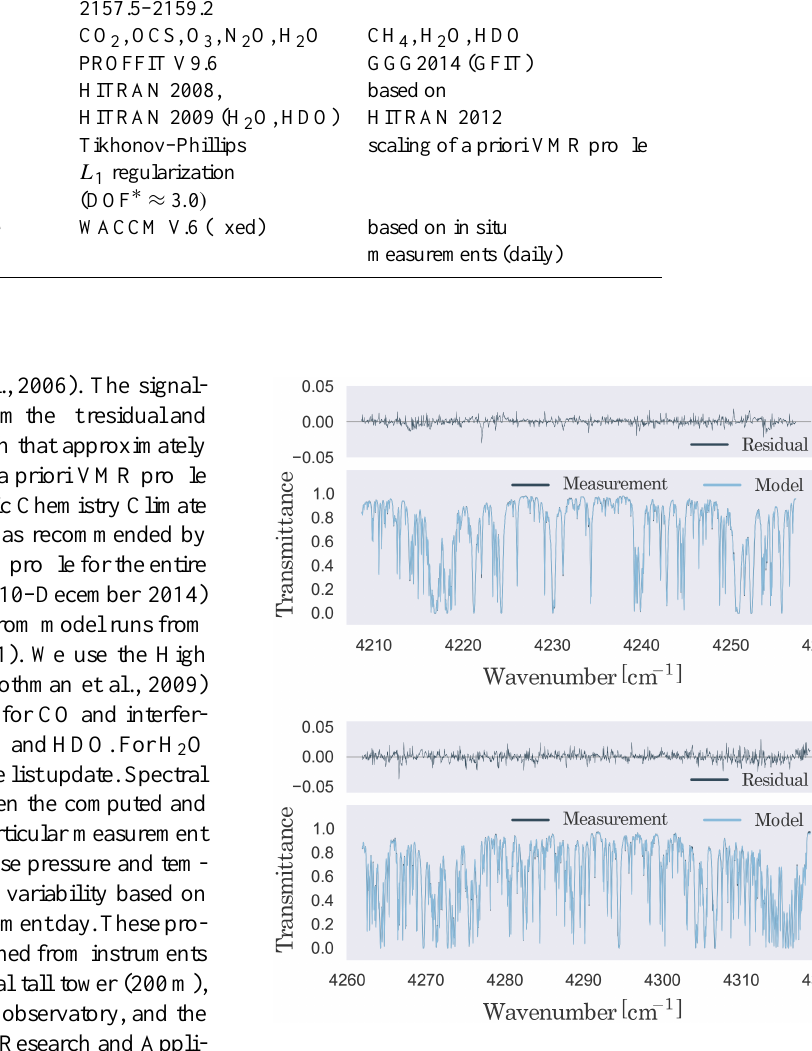
Figure 3. Spectral fits for one particular Karlsruhe spectrum recorded in the NIR; spectral fit and residual for CO in the 4208.7 to 4257.3cm − 1 (upper panel) and 4262.0 to 4328.8cm − 1 (lower panel) spectral